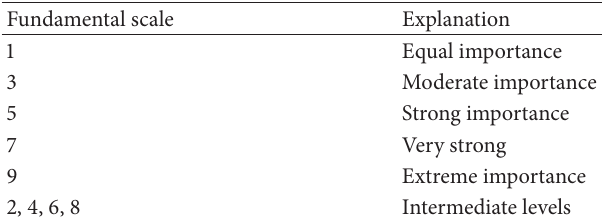
Table 1: Priority based scale used in